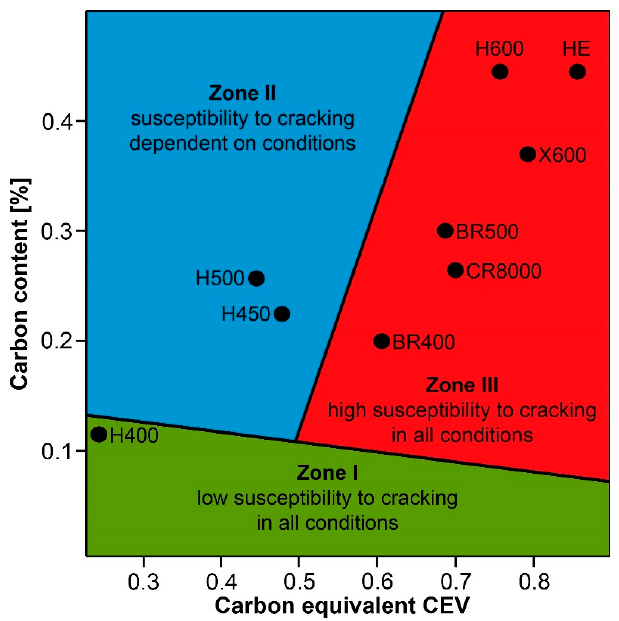
Figure 1. Susceptibility to cracking in function of carbon concentration and carbon equivalent of selected low-alloy abrasive-wear resistant steels: H—Hardox; BR—Brinar; X—XAR; CR—Creusabro. Based on data in Table 3 and [40].